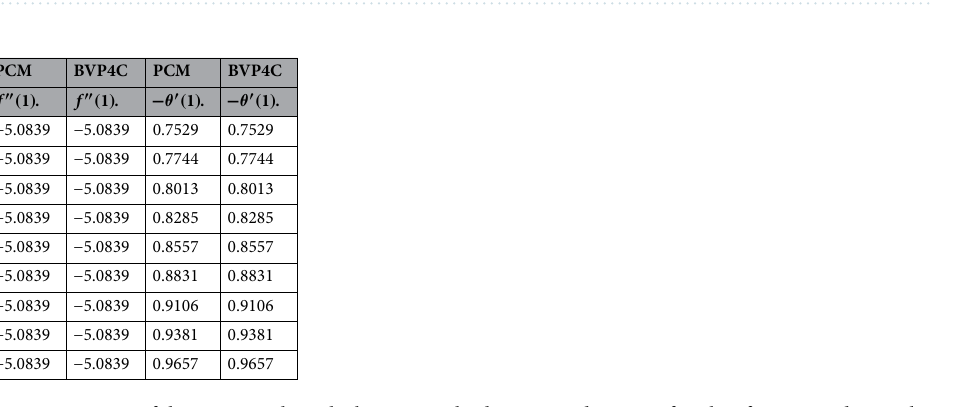
Table 3. Comparison of the numerical results by two methods PCM and BVP4C for Skin friction and Nusselt number, with various physical parameters.